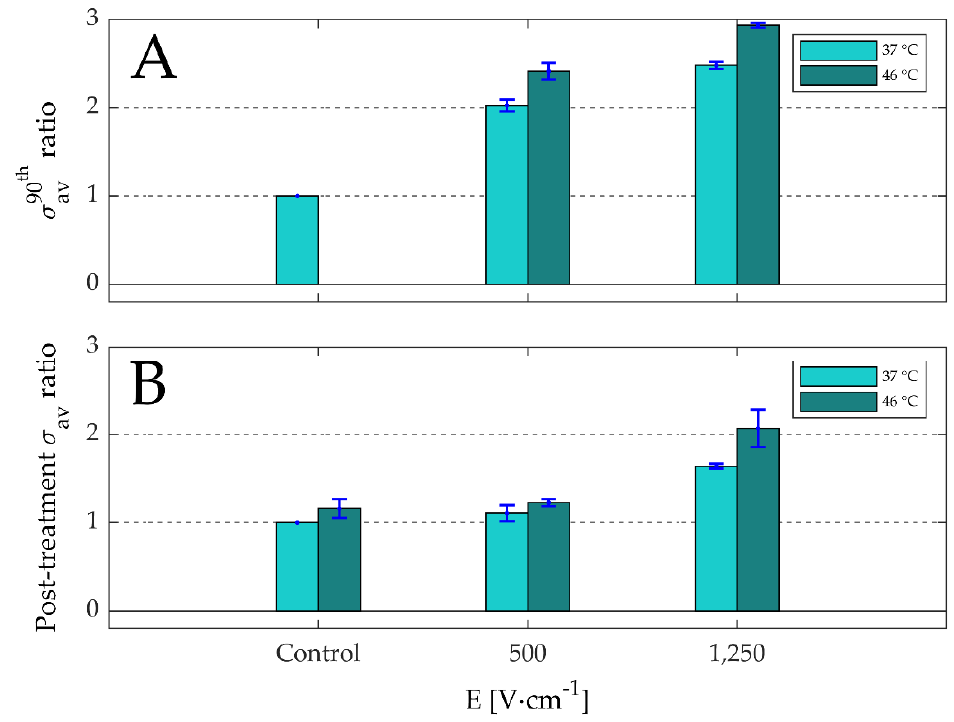
Figure 7. The ratios of the average electrical conductivities ( σ av [S · m − 1 ]) of the 90th pulse ( A ) and post-treatment ( B ) with respect to the post-treatment σ av of the control at 37 ◦ C (0.75 S · m − 1 ) are shown as a function of the electric-field strength (E [V · cm − 1 ]) and target temperature (n = 3; including ± SD). The data are provided in Supplementary Materials. Note that the post-treatment σ av was measured at about 30 s after the 90th pulse.